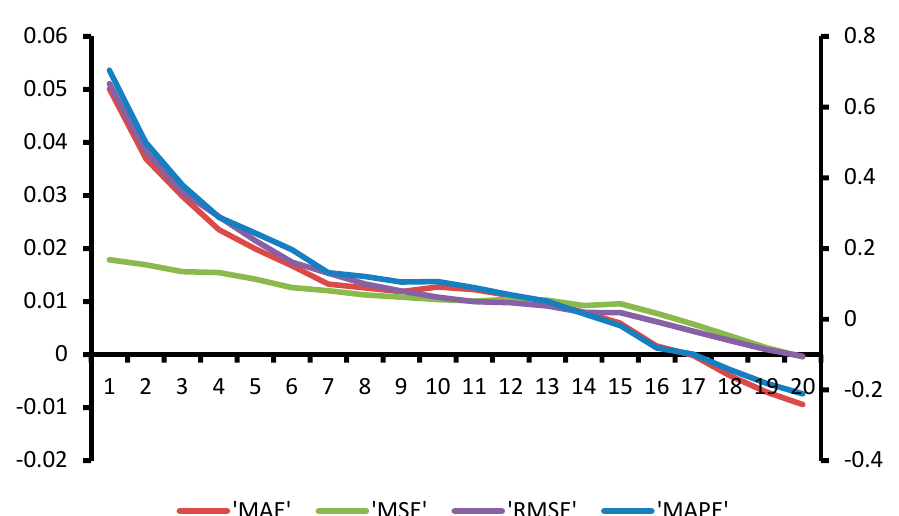
Figure 6. Differential errors between predictions when using prices of CO 2 emission allowances only and when the electricity price trend is also used as an input variable.